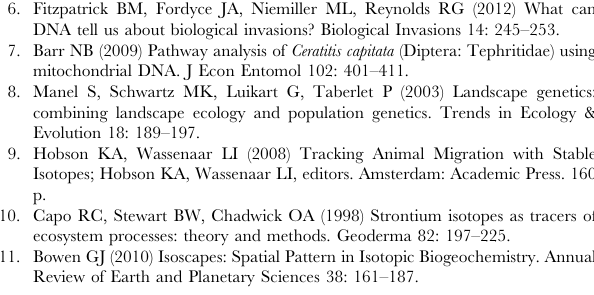
Table S3 Typical instrument operating conditions of the Victoria University Nu MC-ICP-MS and the DSN-100 parameters used for Pb isotope analysis. Table S4 Pair-wise tests of regional differences for H. armigera populations, showing significant differences between the collection regions. Generated by PERMA- NOVA analyses of the multivariate datasets (using Euclidean distance resemblance matrices). { = p , 0.10; * = p , 0.05; ** = p , 0.01. Table S5 Relative contribution of the individual mark- ers to the CAP regional grouping. Expressed as Pearson’s correlation coefficient (i.e., linear measure of assocaition) between the individual markers (ignoring all others) and the CAP ordination axes within the mulitvariate data cloud. 2-sided significance test expressed as { = 10%; * = 5%; ** = 1%.; 2008 data df = 16, 2009 df = 18. 2009 data is an optimized suite. Table S6 H. armigera wing d 2 H summary table. Showing regional d 2 H M averages 6 1SD; values within a row that are followed by a different letter are significantly different (Fishers unrestricted LSD = 5%). Table S7 Retrospective power analyses for H. armigera d 2 H. To detect significant differences between the regional means ( D % ), at a two-sided significance level of 0.05 with a power of 0.90 using a two-sample t-test, the calculated sample size (n) would be required for each sample. A standard deviation pooled across all regions was used in each power analysis. Table S8 H. armigera 87 Sr/ 86 Sr summary table. Showing regional 87 Sr/ 86 Sr averages 6 1SD; values within a row that are followed by a different letter are significantly different (Fishers unrestricted LSD = 5%). n = 6 for each region. Table S9 Retrospective power analysis for the H. armigera 87 Sr/ 86 Sr data. To detect significant differences between the regional means ( D ), at a two-sided significance level of 0.05 with a power of 0.90 using a two-sample t-test, replication of the calculated n for each sample is required.